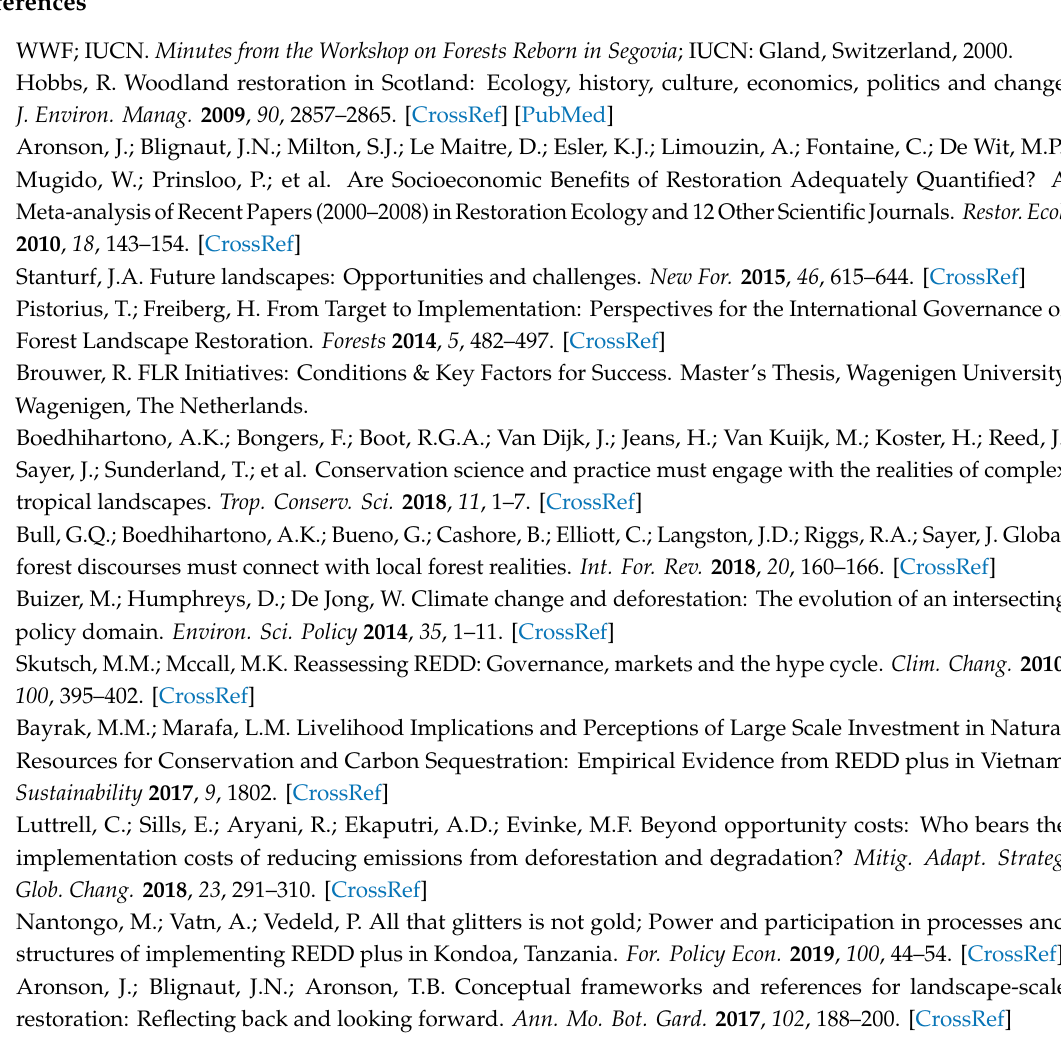
Table S1: Background on the local